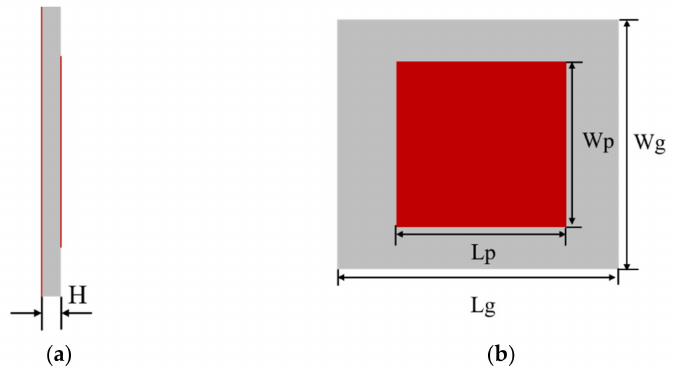
Figure 7. The schematic configuration of the AMC unit: ( a ) the side view and ( b ) the top view.